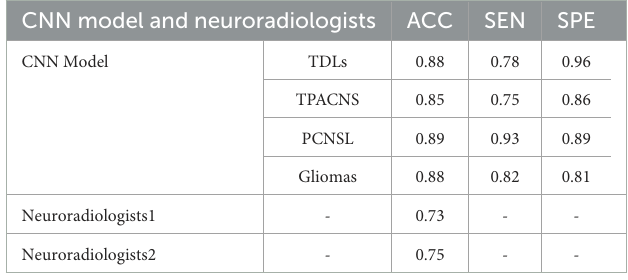
TABLE 2 Diagnostic performance of the CNN model and